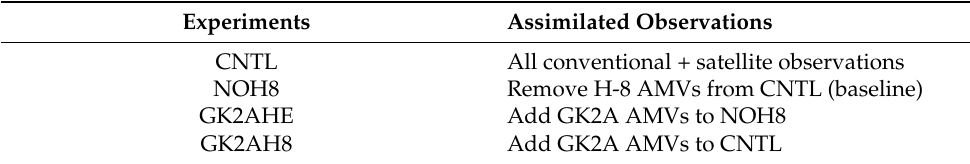
Table 2. The list of